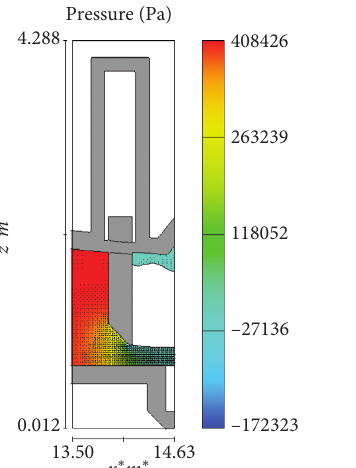
Figure 23: Pressure distribution under the gate for 20% opening mode (100% valve opening).